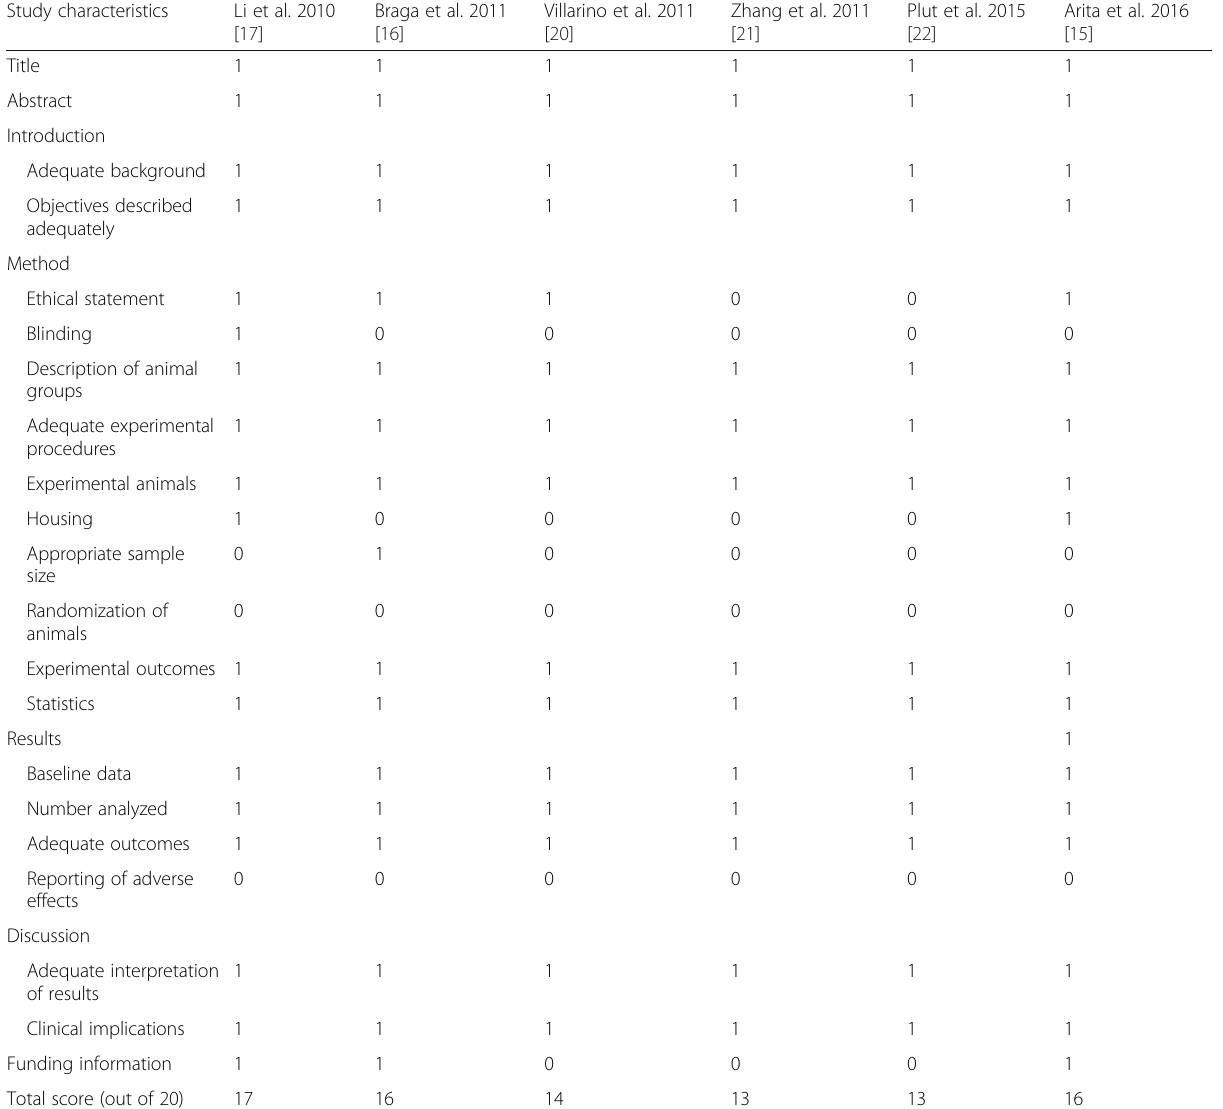
Table 3 Results of the quality assessment of included studies Study